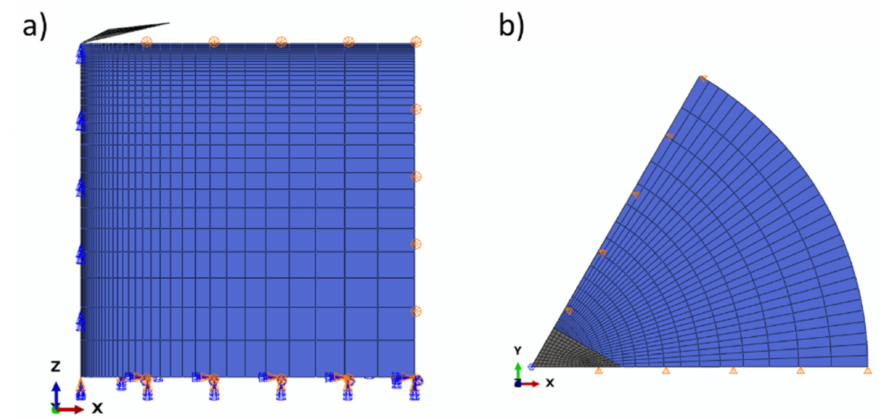
Figure 1. Illustration of the mesh and boundary conditions of the numerical model used for the de- termination of the yield strength by parametric identification: ( a ) view in a radial plane, ( b ) top view.